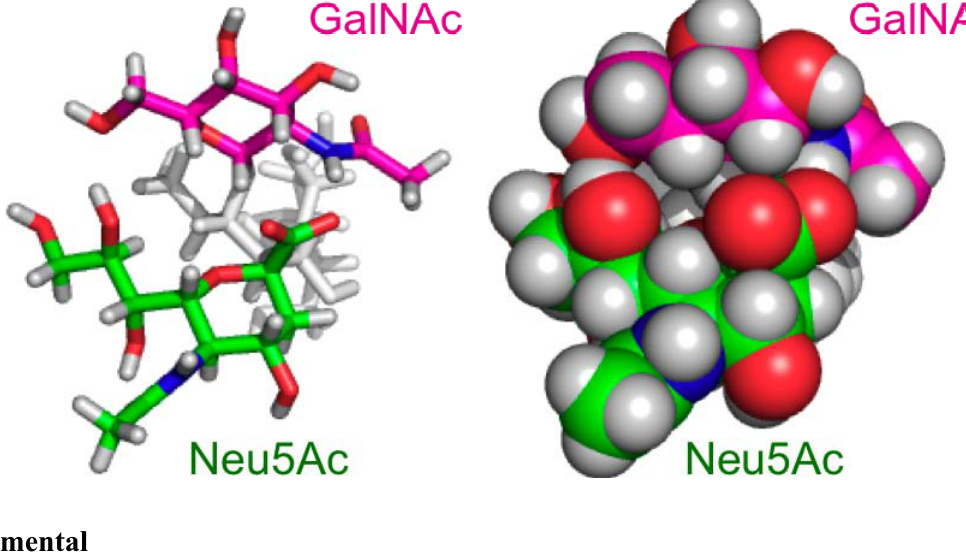
Figure 5. Three-dimensional structural model of one of the major conformers of the GM2 tetrasaccharide. Cylinder ( left ) and space-filling ( right ) models are shown in the same